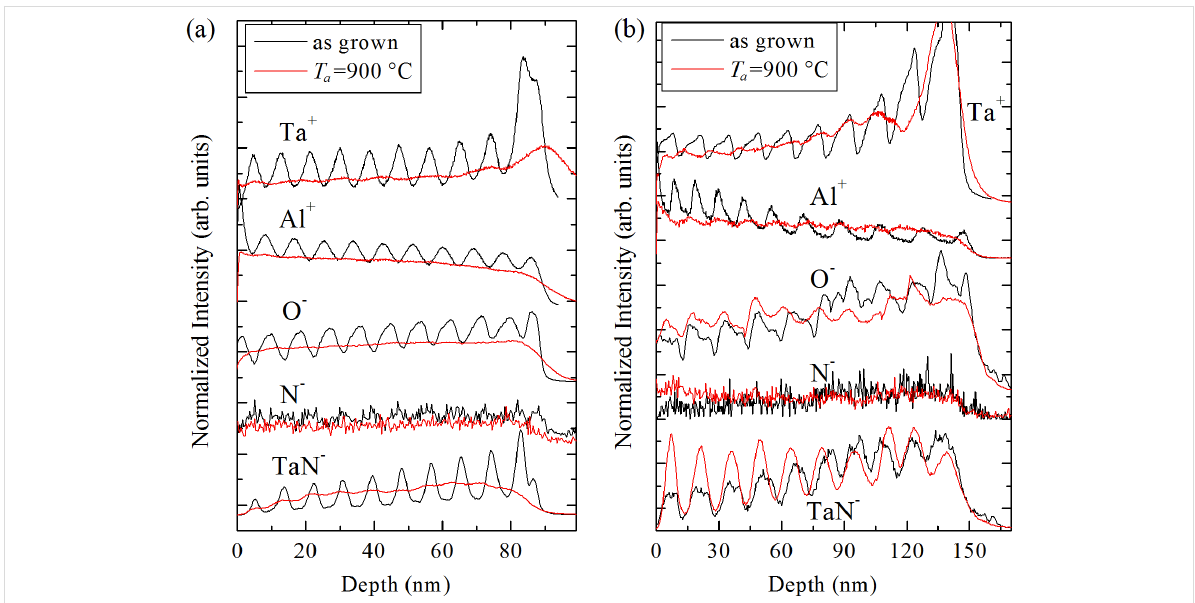
Figure 4: SIMS profiles of as-grown and annealed MLs for two different nominal thicknesses of the metallic layers: (a) 4 nm for ML4m and ML4m9 and (b) 12 nm for ML12m and ML12m9.